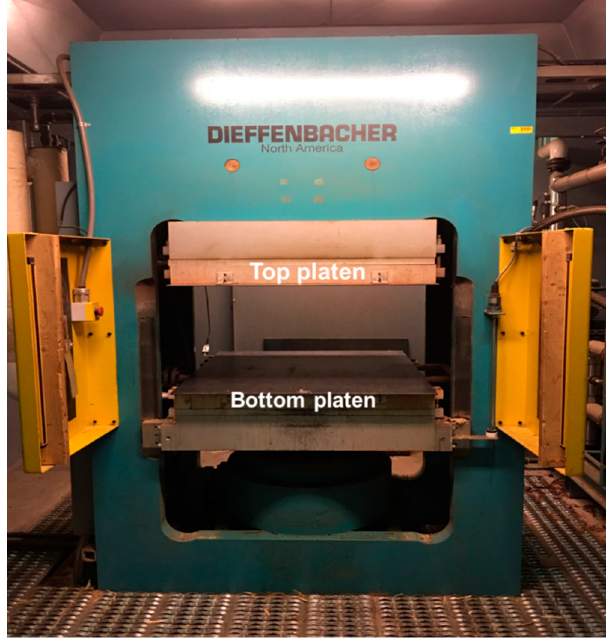
Figure 1 . Steam injection hot press used for THM densification treatment. Figure 1. Steam injection hot press used for THM densification